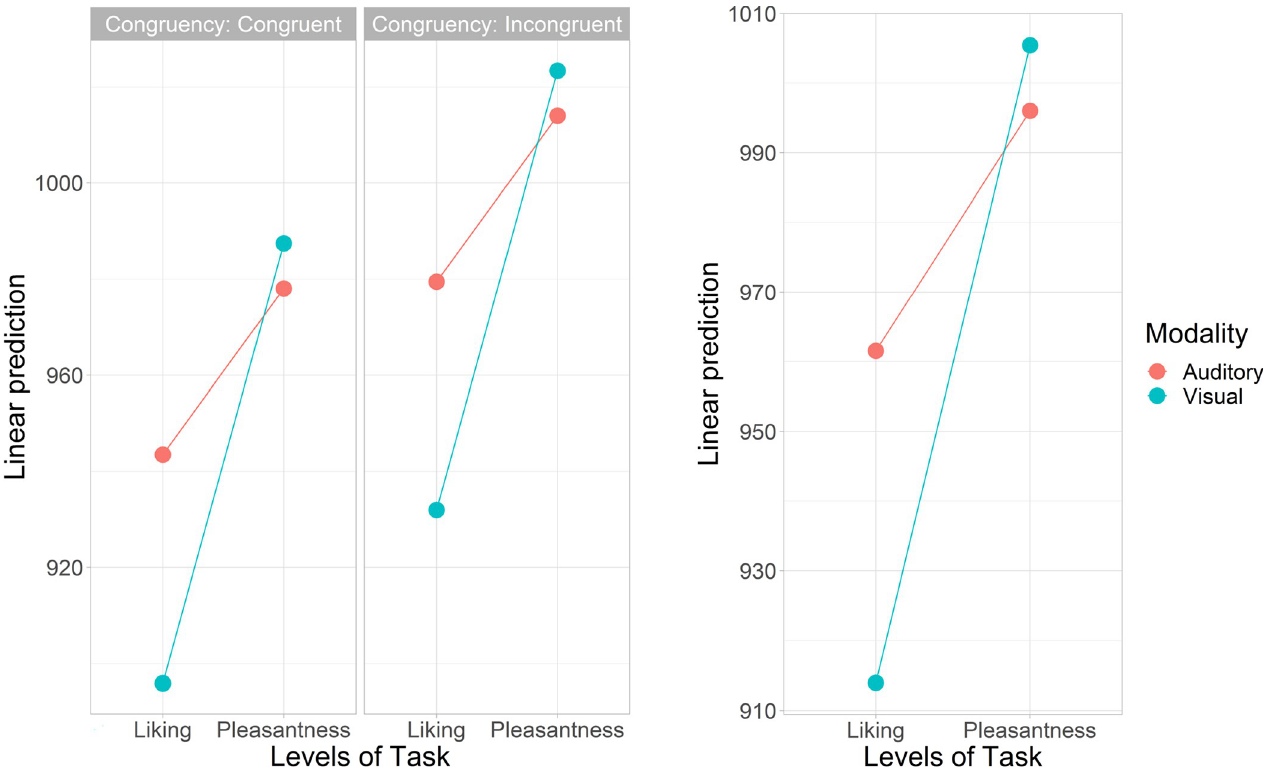
Fig 3. Linear predictions of the response times. Linear predictions for the priming effect in dependence to the sensory modality and task for congruent and incongruent conditions (left), and across congruency (right). The y-axis indicates the response time in milliseconds.